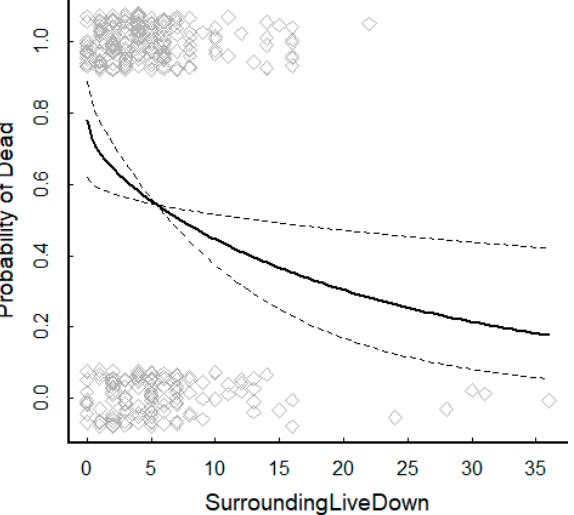
Figure 5. Relationship between probability of mortality of a tree and the number of surrounding live or downed trees. Points are individual trees that either died (top of axis) or remained alive (bottom of axis). Dashed lines are 90% confidence intervals on the relationship. All other variables are held at their mean values.